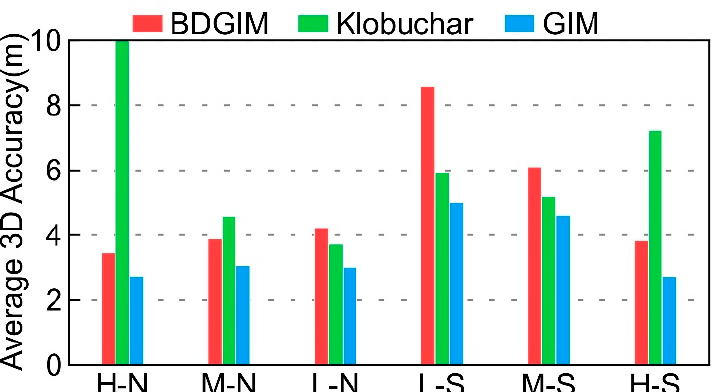
Figure 6. The average 3D positioning accuracies with the BDGIM, the Klobuchar model and the GIM in different regions of the world. The letters H, M and L represent high, middle and low latitudes, respectively, while N and S represent the northern and southern hemispheres, respectively.